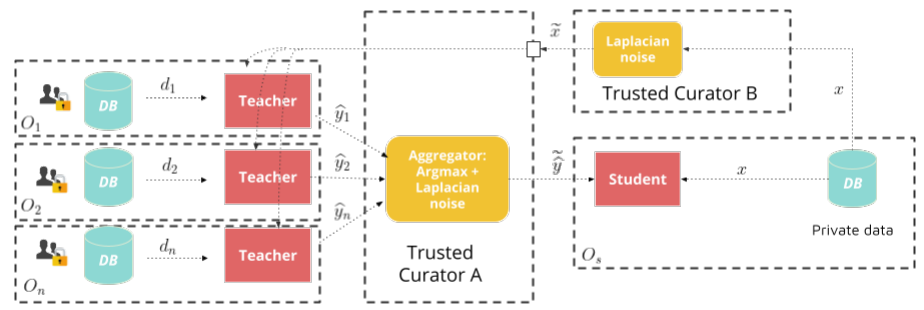
Figure 6. PATE with protected student